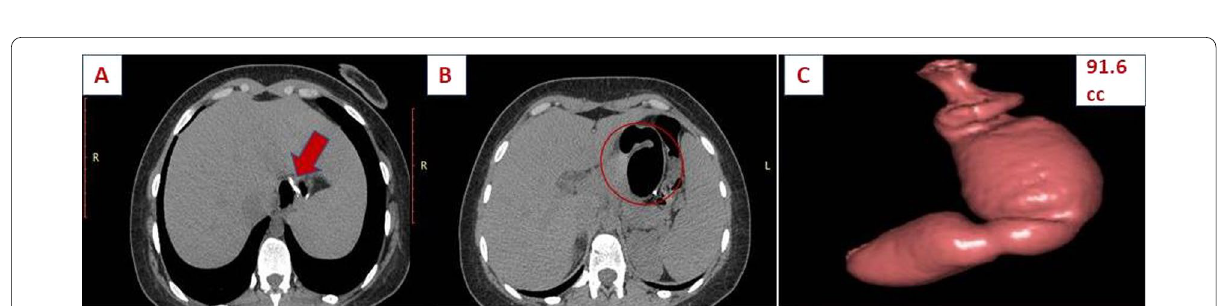
Fig. 5 A 34‑year‑old obese female (BMI 41.6) with postoperative gastric volume is 91.6 cc. Preoperative weight and 1‑year postoperative = weight were 116 kg and 68 kg, respectively. Weight reduction percentage is 41.4%, and 1‑year postoperative BMI is 24.3. % of loss from the excess weight 88.8%. A, B CT abdomen are showing staples (arrow) and gastric pouch (circle). C 3D CT gastric volumetry showing gastric volume of = 91.6 cc